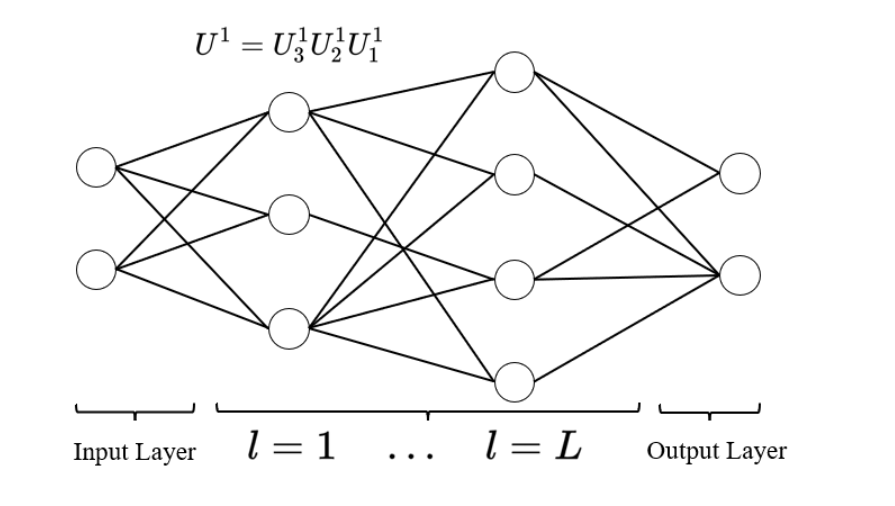
Figure 2. The structure of a QNN